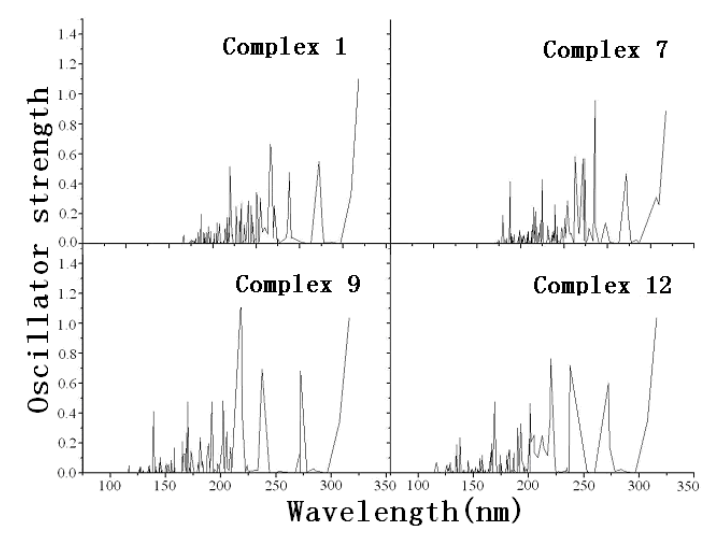
Fig. 3 Electronic spectra of complexes 1, 7, 9 and